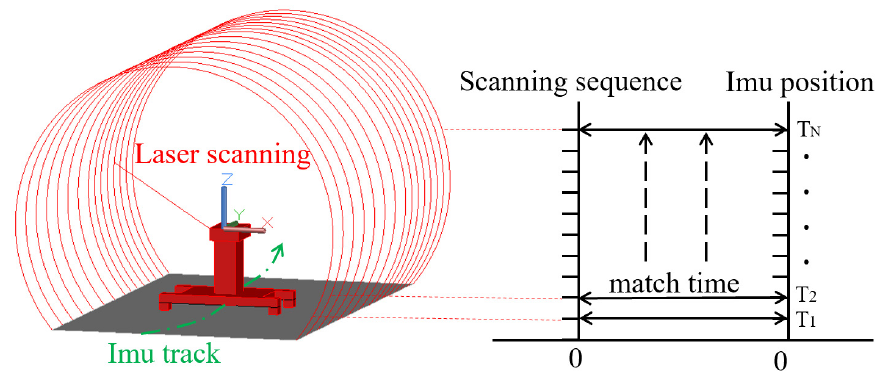
Figure 10. Fixed-time synchronization of laser scanning data and IMU data.